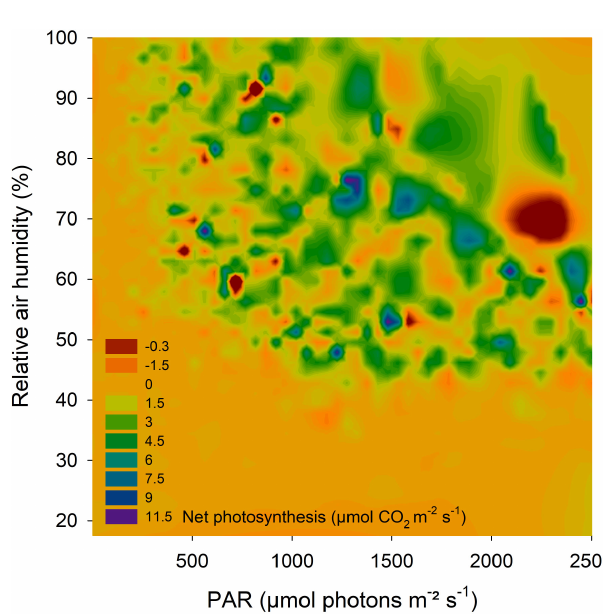
Figure 7. Contour plot of net photosynthesis of the Boodjamulla biocrust based on linear interpolation between measured values. Shown is the active period from November 2010 to April 2011. Net photosynthesis is related to relative air humidity and photosynthetic active radiation (PAR). No dark respiration values shown. Colour key: yellow means no activity, orange to red means CO 2 loss dur- ing the day (supersaturation) and light green to violet means CO 2